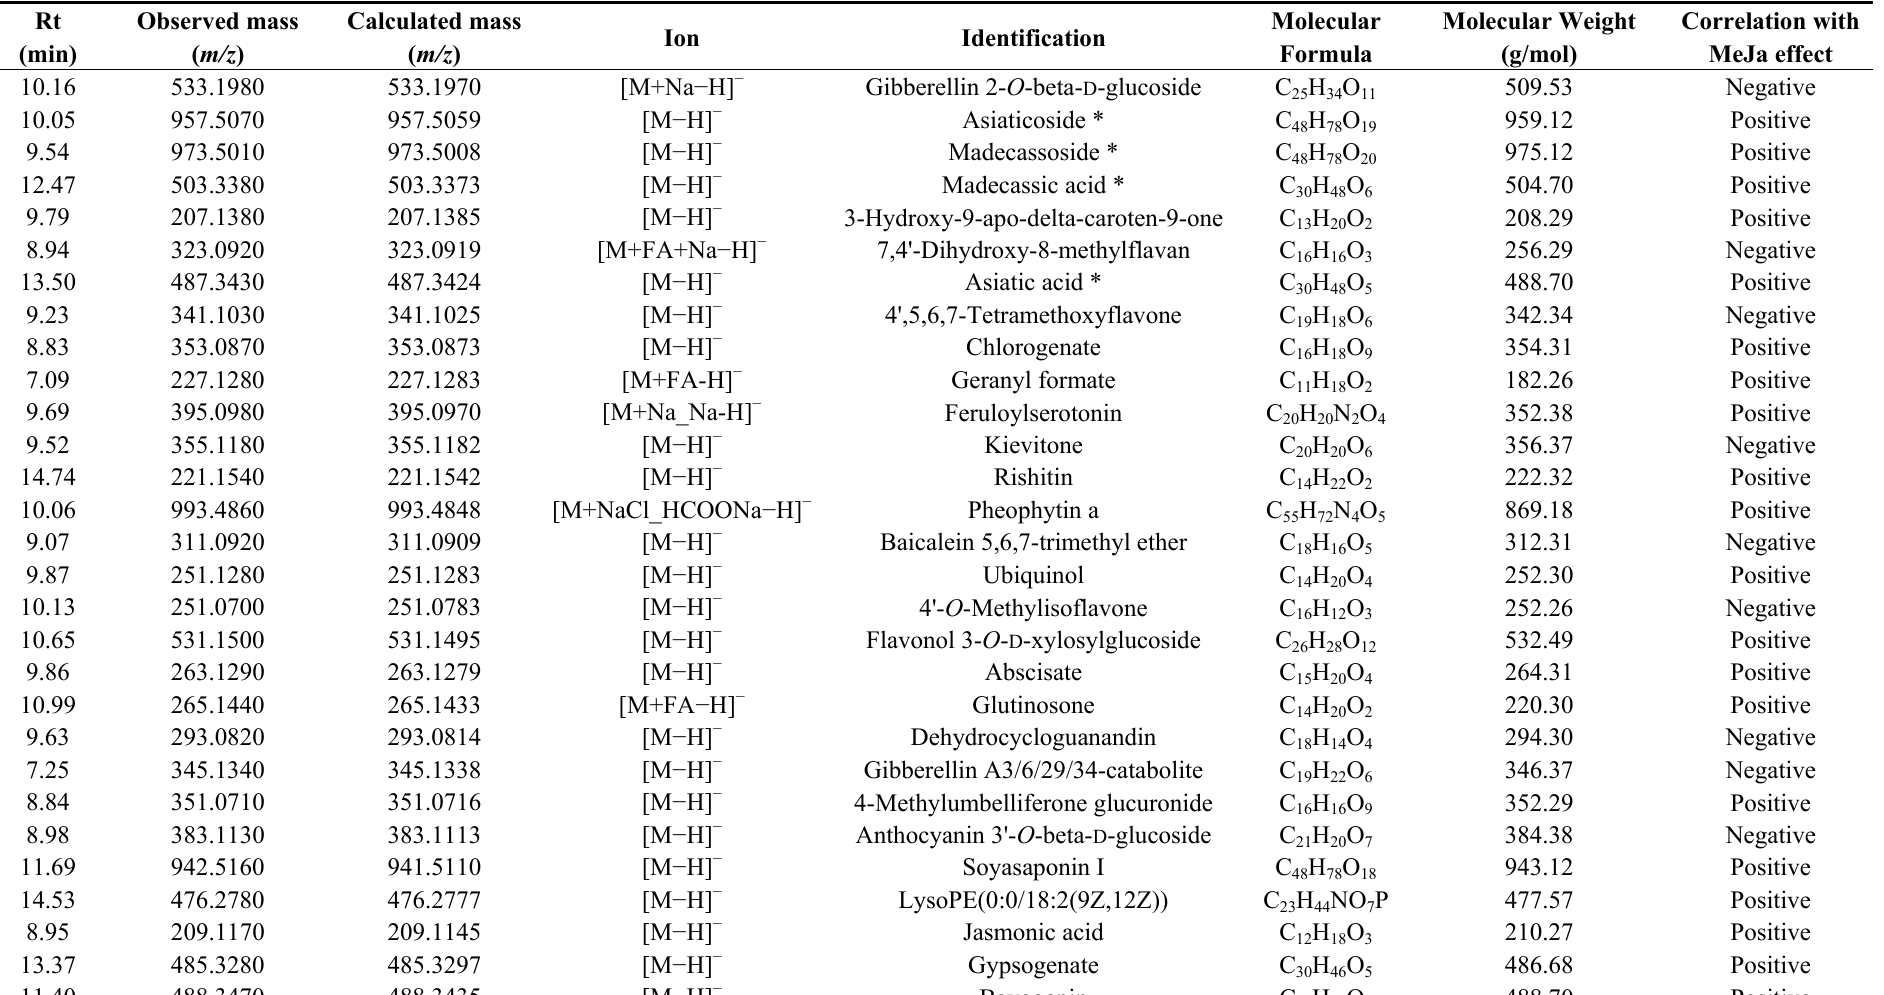
Table 1. Selected, tentatively identified metabolites in C. asiatica cells responding to 0.2 mM MeJa treatment. Metabolites are listed according to decreasing variable importance in projection (VIP)